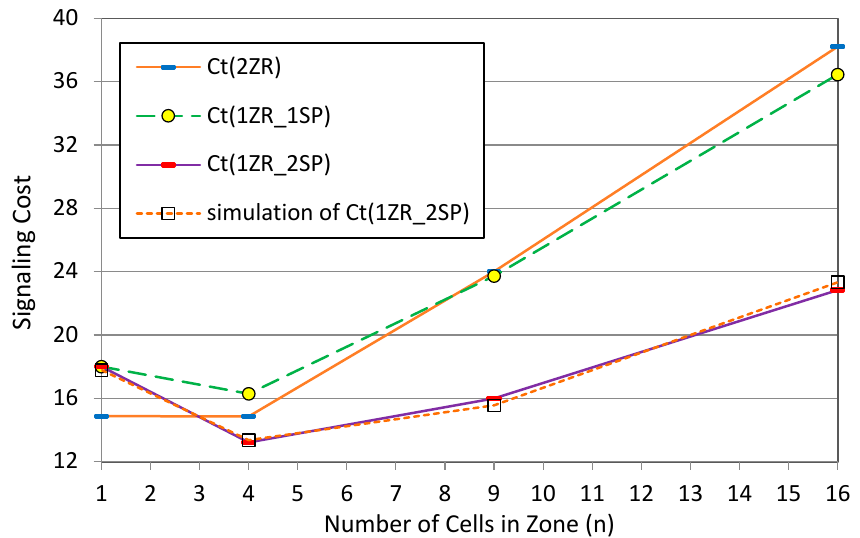
Figure 11. Total signaling cost for various numbers of cells in a zone ( λ m = 4, λ c = 2, q = 0.3).